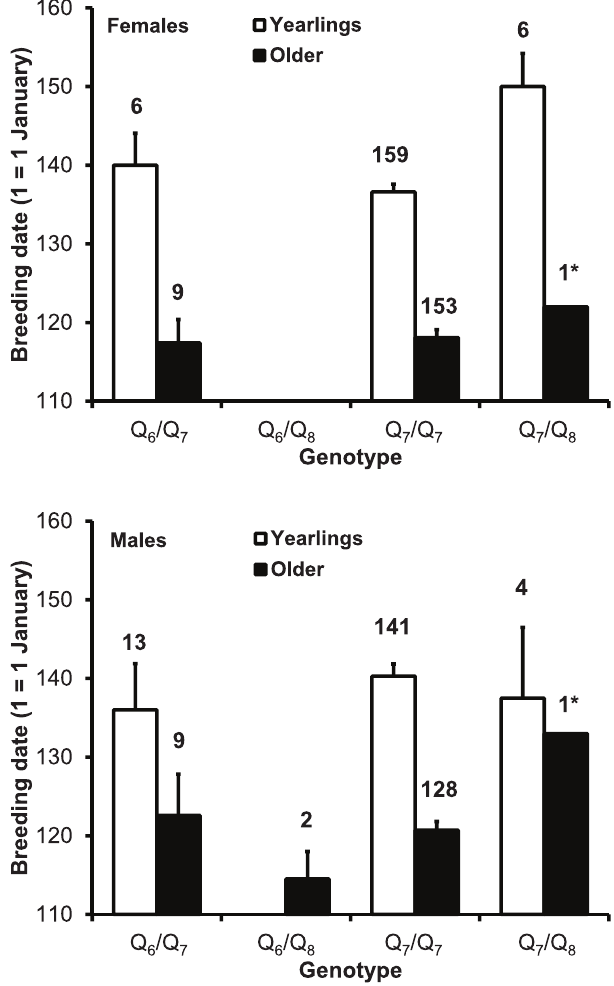
Figure 1. Mean ( + s.e.) breeding date of the genotypes in the sex by age classes of the barn swallow. Numbers in the body of the graphs are sample sizes. Breeding date data of the single Q 7 /Q 8 older female or male (denoted by 1*) are reported for completeness but are not included in the statistical analyses. The difference between yearling female Q 7 /Q 7 and Q 7 /Q 8 was significant (P , 0.05, see